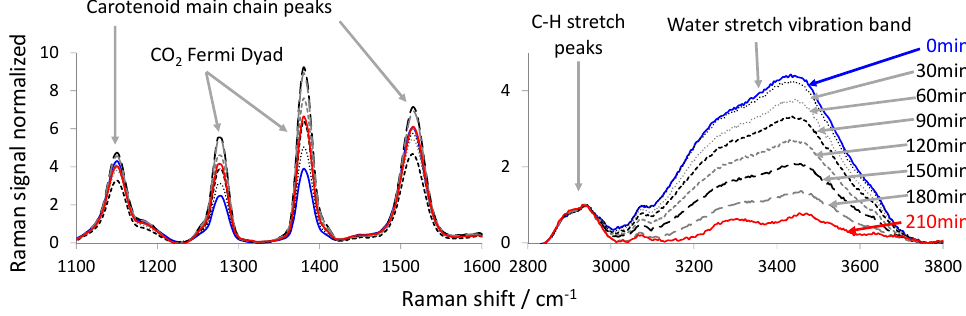
Figure 3. Temporal series of the processed Raman spectra acquired with the 532 nm excitation Raman sensor during an example drying experiment of a slice of persimmon.